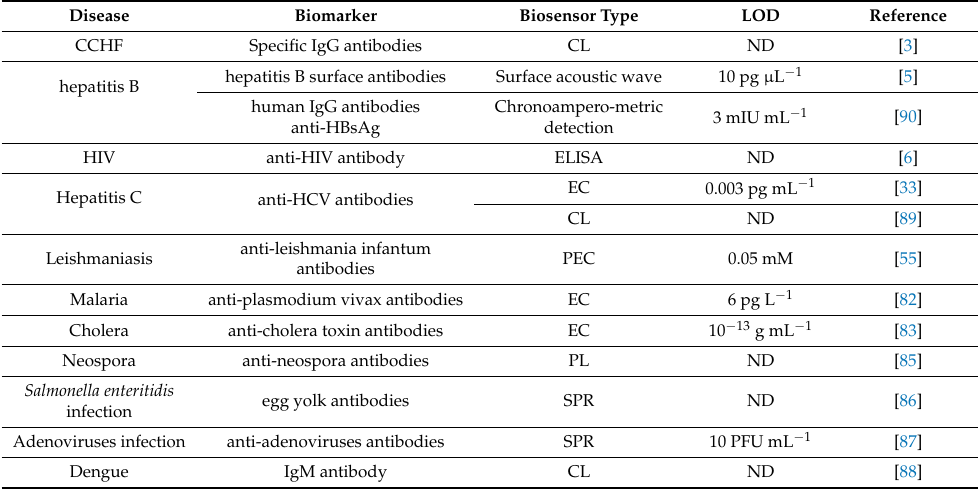
Table 1. Biosensors constructed for biomarker detection of infectious